Question: Give a one-sentence summary of this figure.
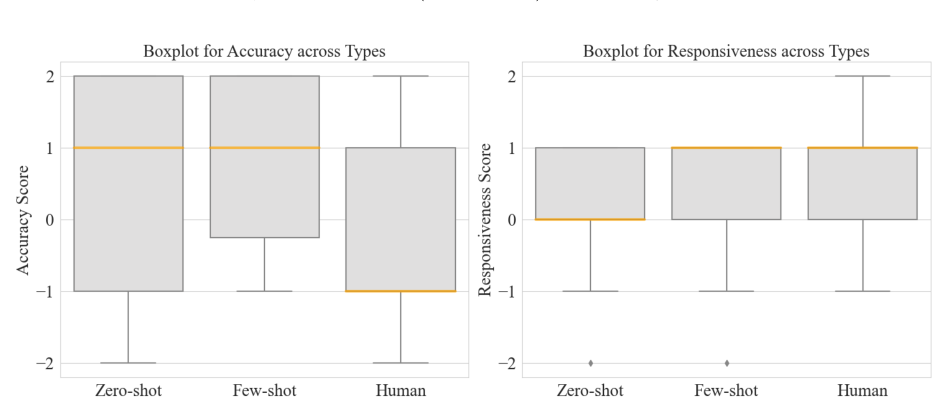
Answer: Distribution of accuracy and responsiveness scores from the lesson Giving Effective Praise